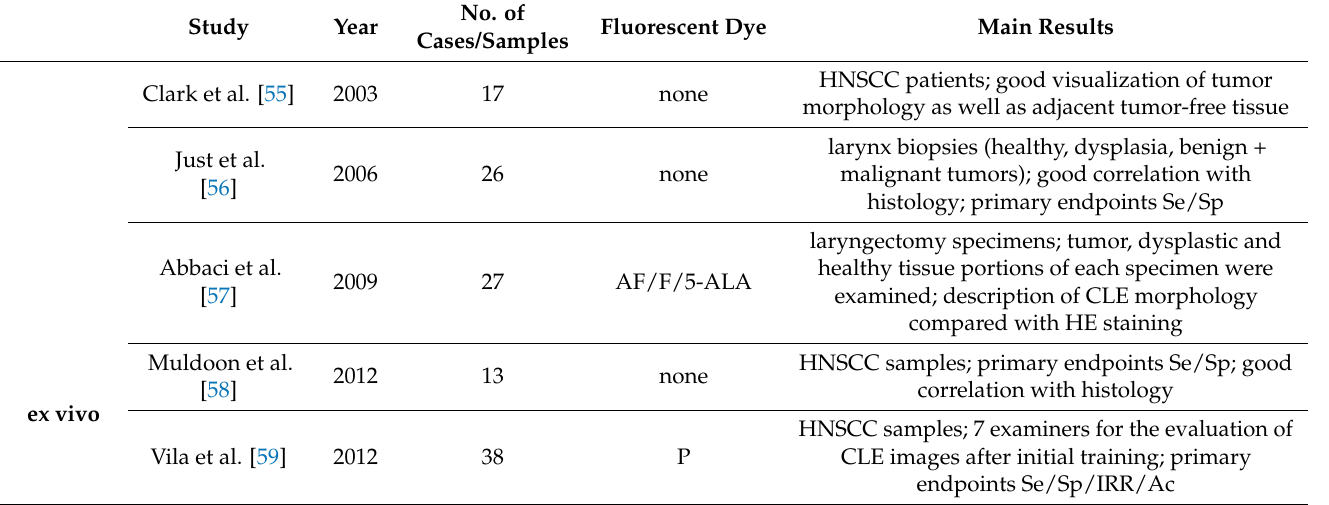
Table 2. CLE studies head and neck